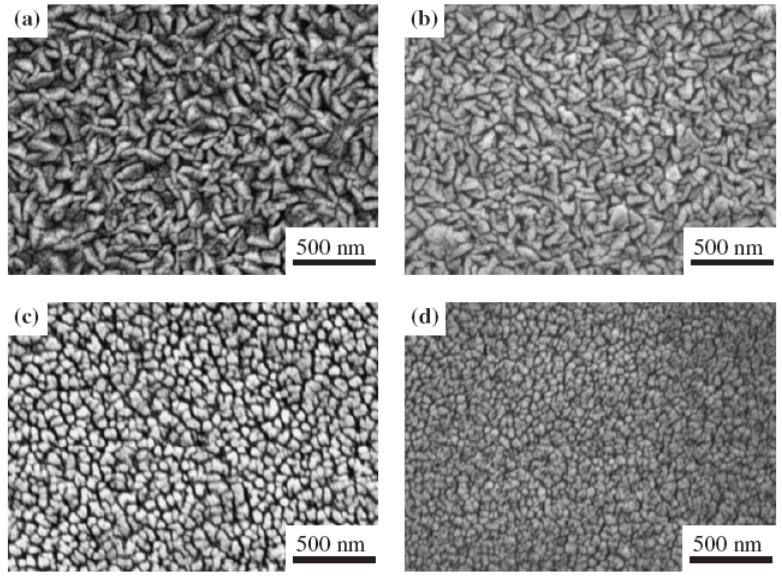
Figure 2. FE-SEM images of the (a) undoped ZnO and co-sputtered Al–ZnO films at theoretical Al atomic ratios of (b) 7.5, (c) 10, and (d) 12.5 at. %. Reprinted from [18] with permission.